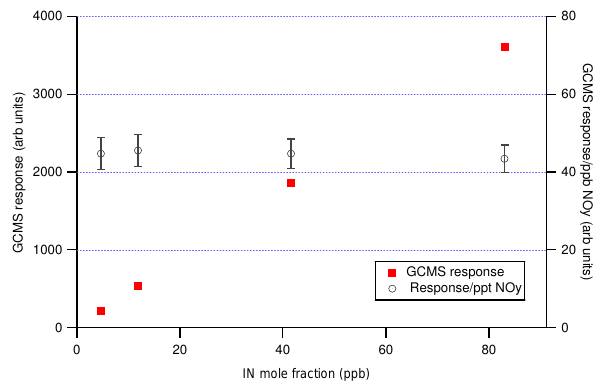
Figure 5. GCMS response and calculated GCMS sensitivity for Z- (4,1)-IN at different mole fractions (measured by CL). The error bars shown are the combined CL and GCMS measurement preci- sions ( ± 8.3%) as discussed in Sect. 4. Table 2. Relative sensitivities of different INs to n-butyl nitrate, us- ing different quantification ions. Relative sensitivity is calculated as peak area per unit mole fraction IN (ion) / peak area of n-butyl ni- trate ( m/z 46) per unit mole fraction n-butyl nitrate. It should be noted that the signal noise is typically a factor of 2 to 3 larger for m/z 46 than for the other